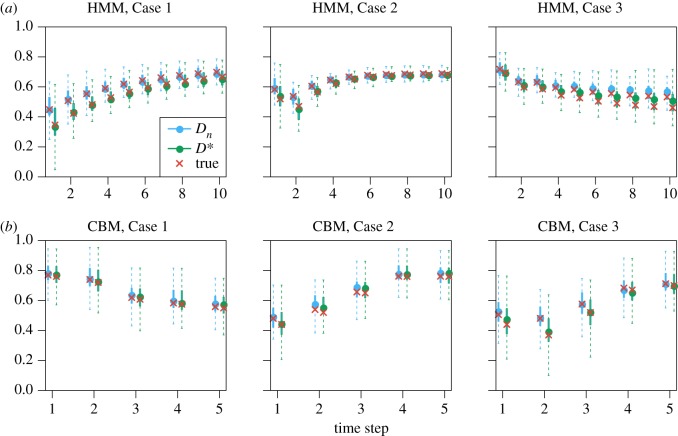
Simulation study: deviation statistics values computed from parameter estimates and true parameters. The estimates of Dn (equation (2.1)) are shown in blue, and the estimates of D* (equation (2.2)) are shown in green as quantiles of the 100 repetitions. The dashed lines represent the full 0–100% quantiles, and the solid lines represent the 25–75% quantiles. The blue dots are the medians. The red crosses are the true values used in the simulation. (a) HMM and (b) CBM.